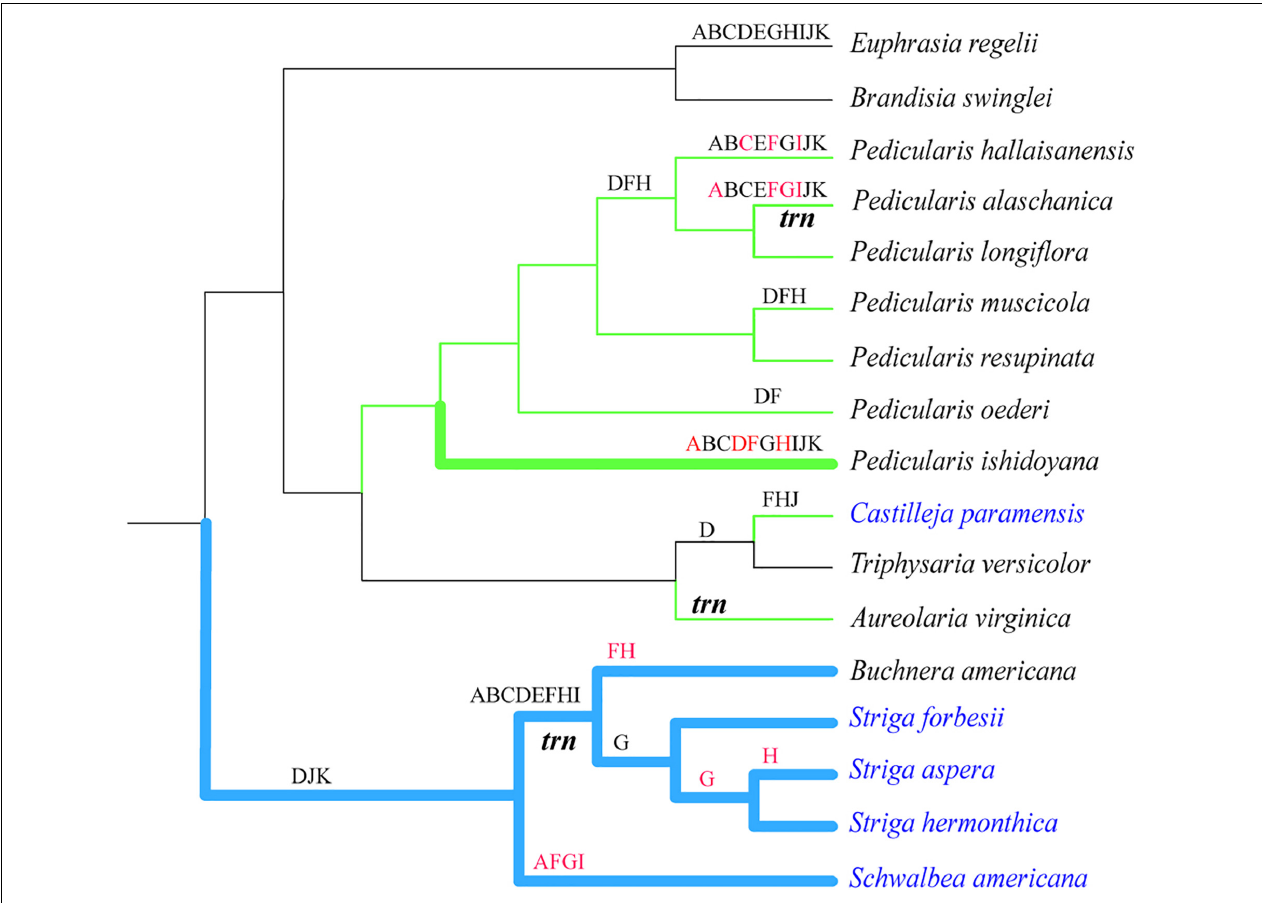
FIGURE 3 | Relationships among phylogeny, lifestyles, structural rearrangements, and gene non-functionalization in hemiparasitic plastomes. ML tree was constructed by using 55 conserved intact genes. Thicken branches represented lineages with the expanded IR region. Blue and green branches showed the lineages with the rearrangement of LSC/SSC and the inverted SSC regions, respectively. Black and red letters above branches represented the pseudogenized and missing ndh genes, respectively. The italic trn indicated the majority of tRNA genes were lost in the lineages. Taxa in black and blue were the facultative and obligate hemiparasites,